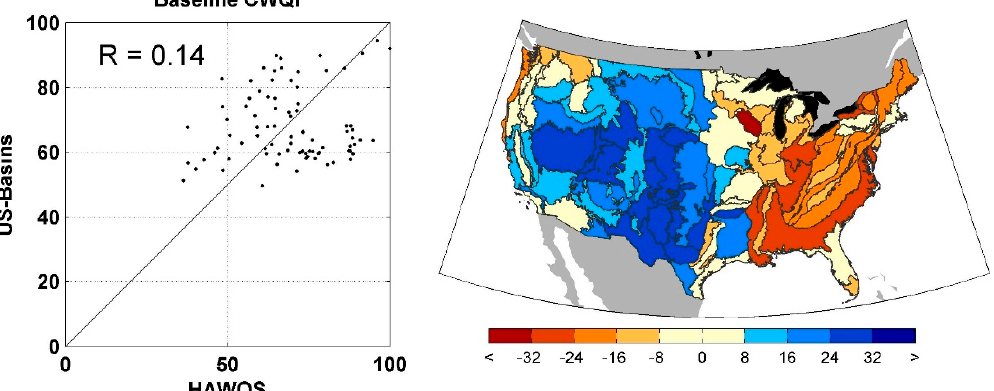
Figure 5. Scatter plot of baseline Water Quality Index (WQI) for HAWQS and US ‐ Basins as well as correlation coefficient (R) and 1:1 line ( left ) and map of difference in WQI between HAWQS and US Basins ( right ), where positive values indicate that HAWQS WQI is higher than US Basins. These are both shown across the 85 Level III ecoregions in contiguous United States (CONUS).